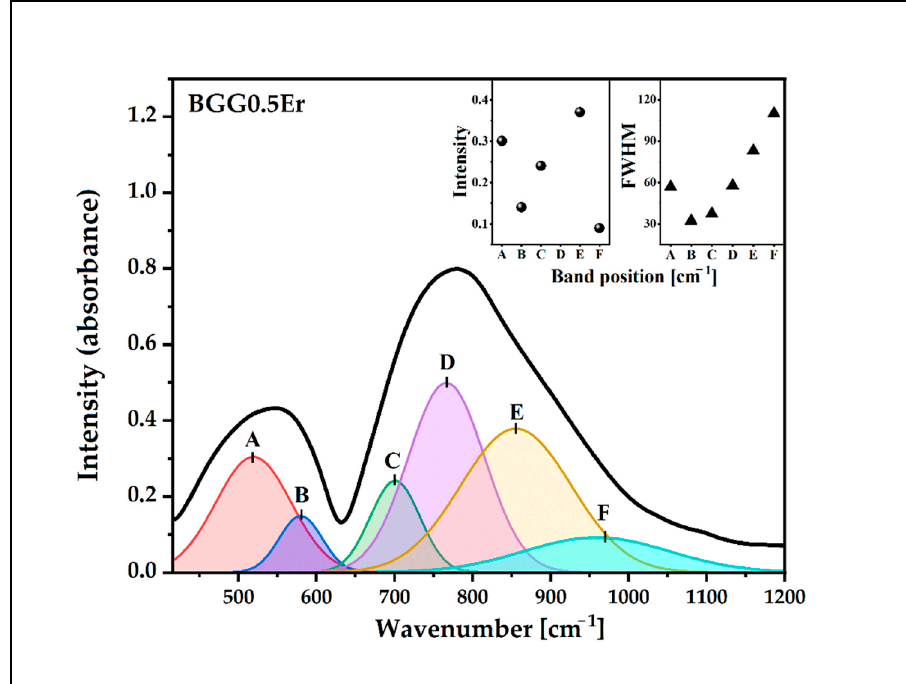
Figure 4. Deconvoluted IR spectrum of BGG0.5Er glass.